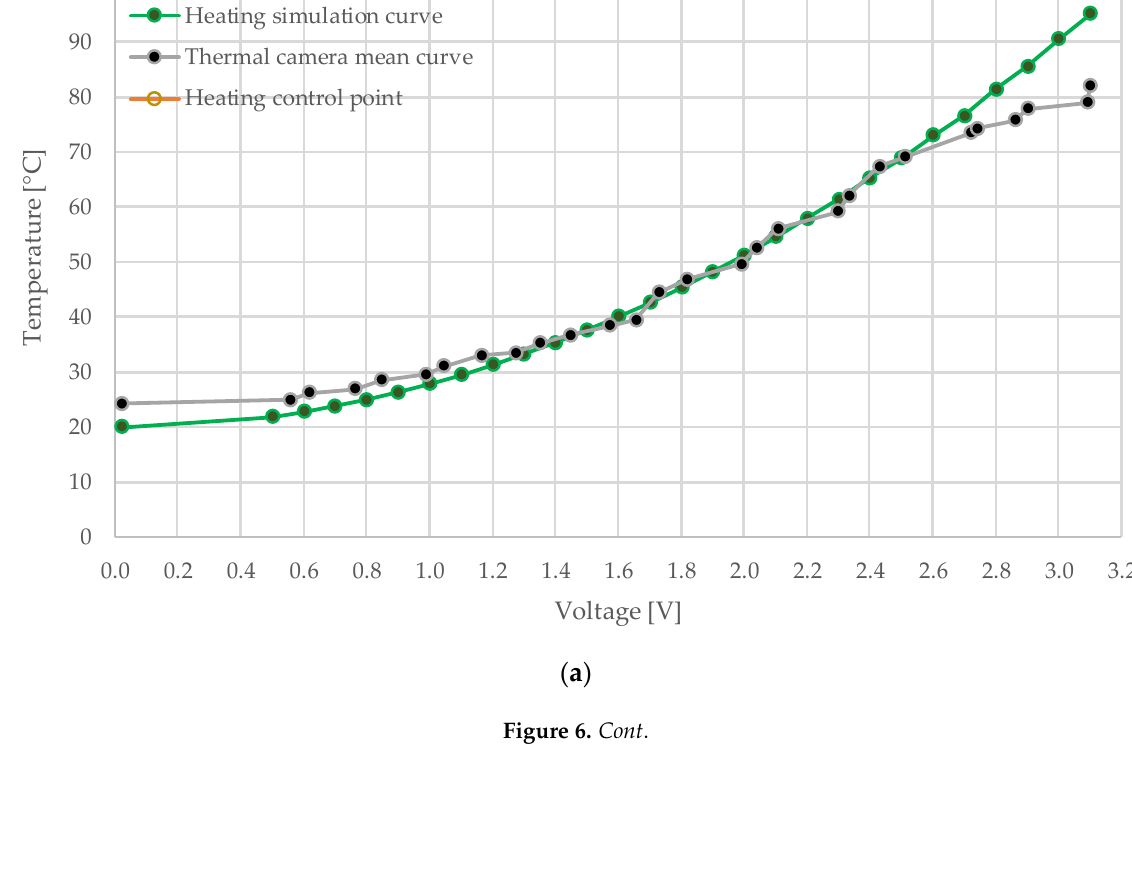
( b ) Figure 6. ( a ) Comparison system characterization between thermal camera mean curve and heating characterization curve behavior simulation based in 0.1 V step changes; ( b ) comparison between power consumption simulation based on re- sistance characterization curve and the mean measurement power consumption vs. temperature curve. Both comparisons have the heating control point highlighted. From the reference point selected, a thermal distribution simulation (Figure 7a) was performed, considering the same electrical and thermal characteristics as used for the